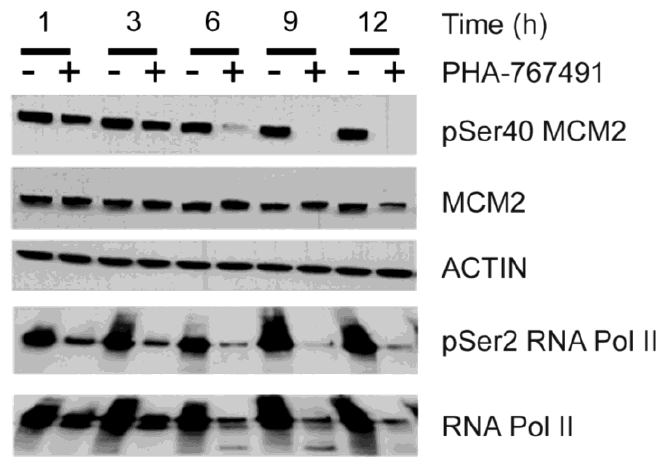
Figure 2. PHA-767491 inhibits both CDC7 and CDK9 in KMS-18 cells. KMS-18 myeloma cells were incubated with 5 μM PHA-767491. Protein extracts were prepared at the indicated time points and analyzed by immunoblotting using the indicated